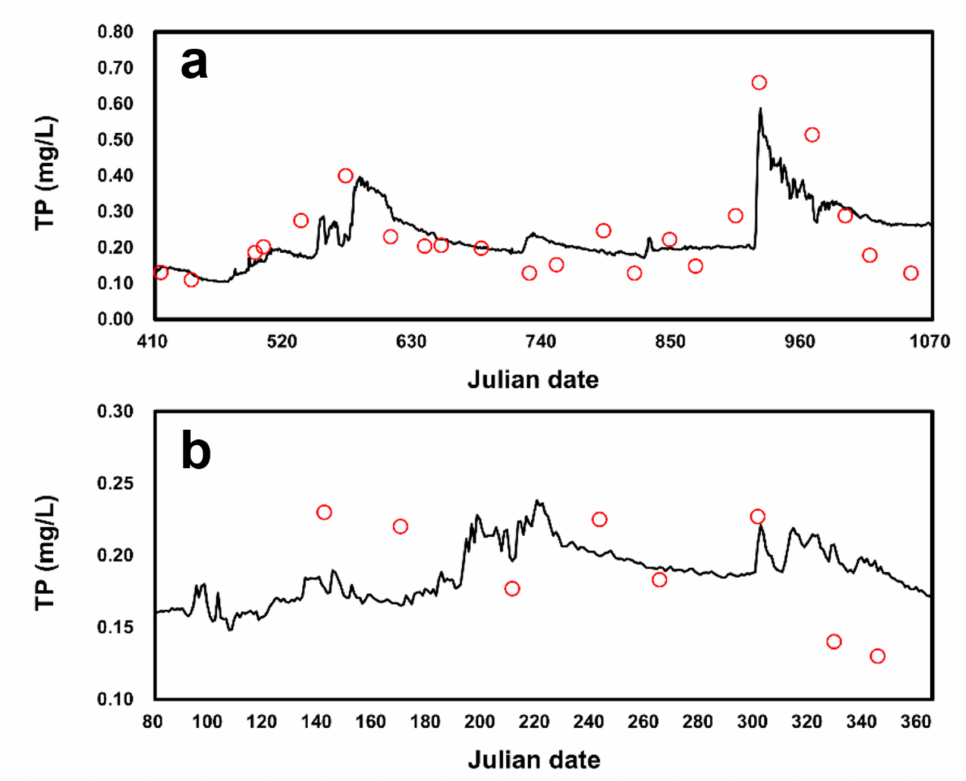
Figure 6. ( a ) Calibration and ( b ) validation result of the T-P concentration of the estuarine reservoir (Zone A).